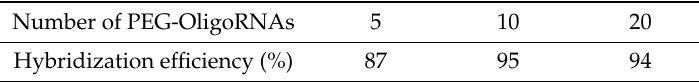
Figure 1. Positions in GLuc mRNA to which each PEG-OligoRNA hybridizes. ( a ) 5 PEG- OligoRNAs/mRNA. ( b ) 10 PEG-OligoRNAs/mRNA. (c) 20 PEG-OligoRNAs/mRNA. A scale bar shows the length of 100 nt. Table 1. Hybridization efficiency determined by HPLC.